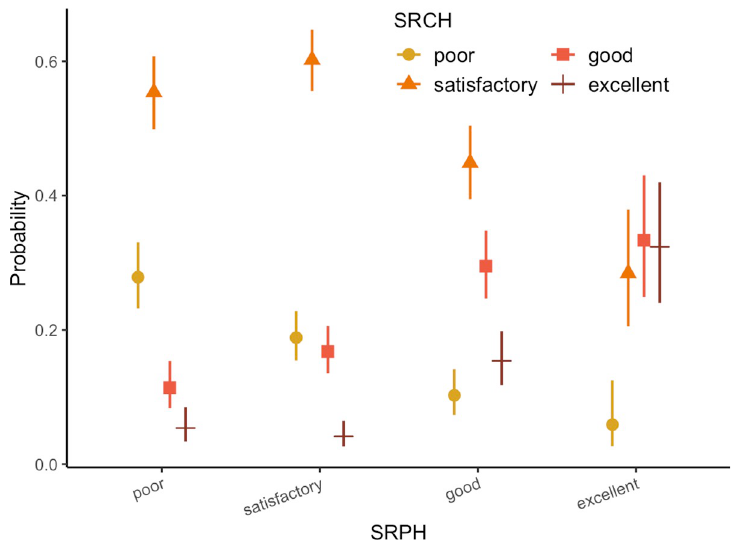
Fig 4. The mean probability of the level of self-reported current health (SRCH) as an adolescent as a function of self-reported past childhood health (SRPH). Whiskers indicate the 95% confidence intervals. Results based on the Bayesian network. The “very poor” category was pooled with the “poor” category due to the small number of responses.